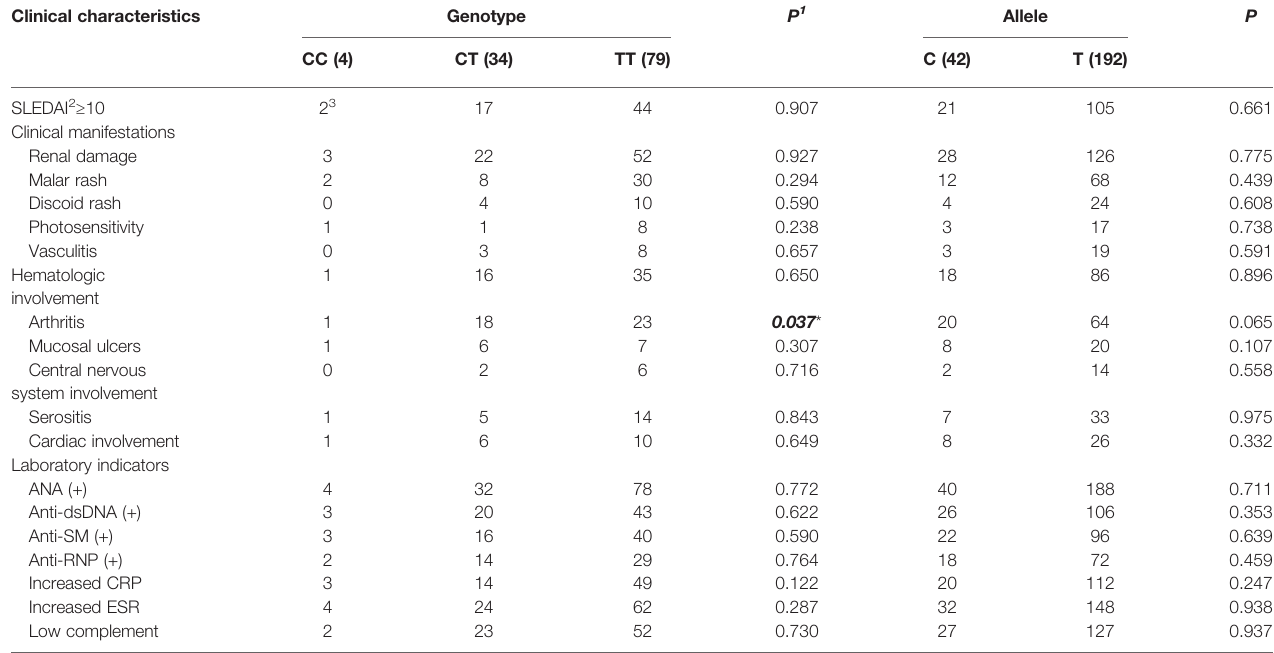
TABLE 4 | The results of genotype-phenotype